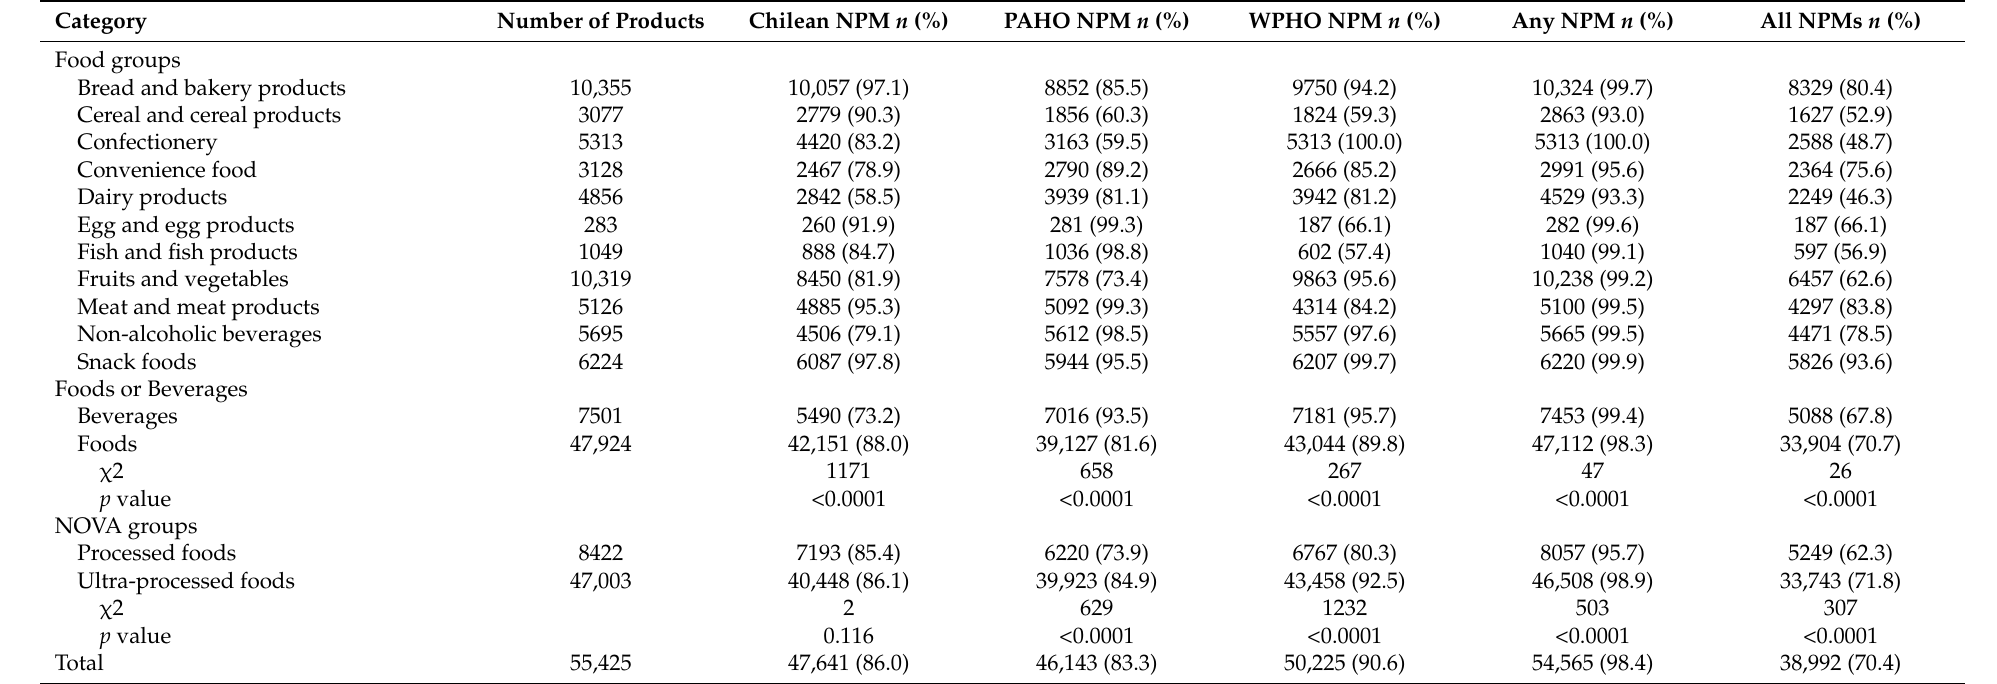
Table 4. Proportion of food products containing at least one negative nutrient in excess under different